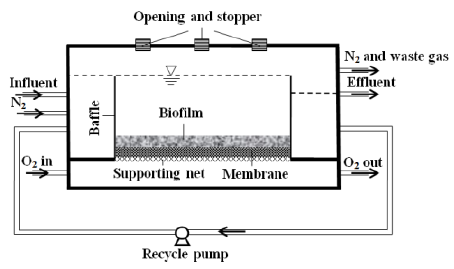
Figure 1. Setup of the membrane-aerated biofilm reactor